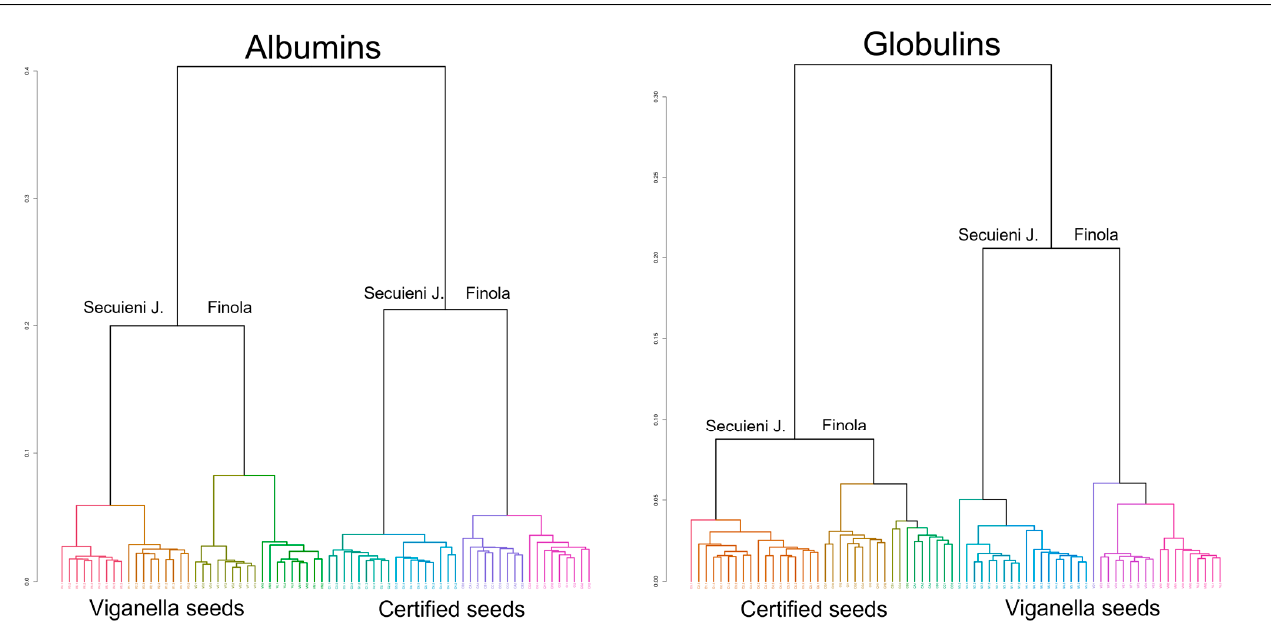
Figure 9. Dendrograms obtained by HCA of the mass spectra of albumin (left) and globulin (right) extracts from hemp seeds, according to their variety (Finola and Secuieni J.) and origin (certified and harvested seeds from the Viganella site).